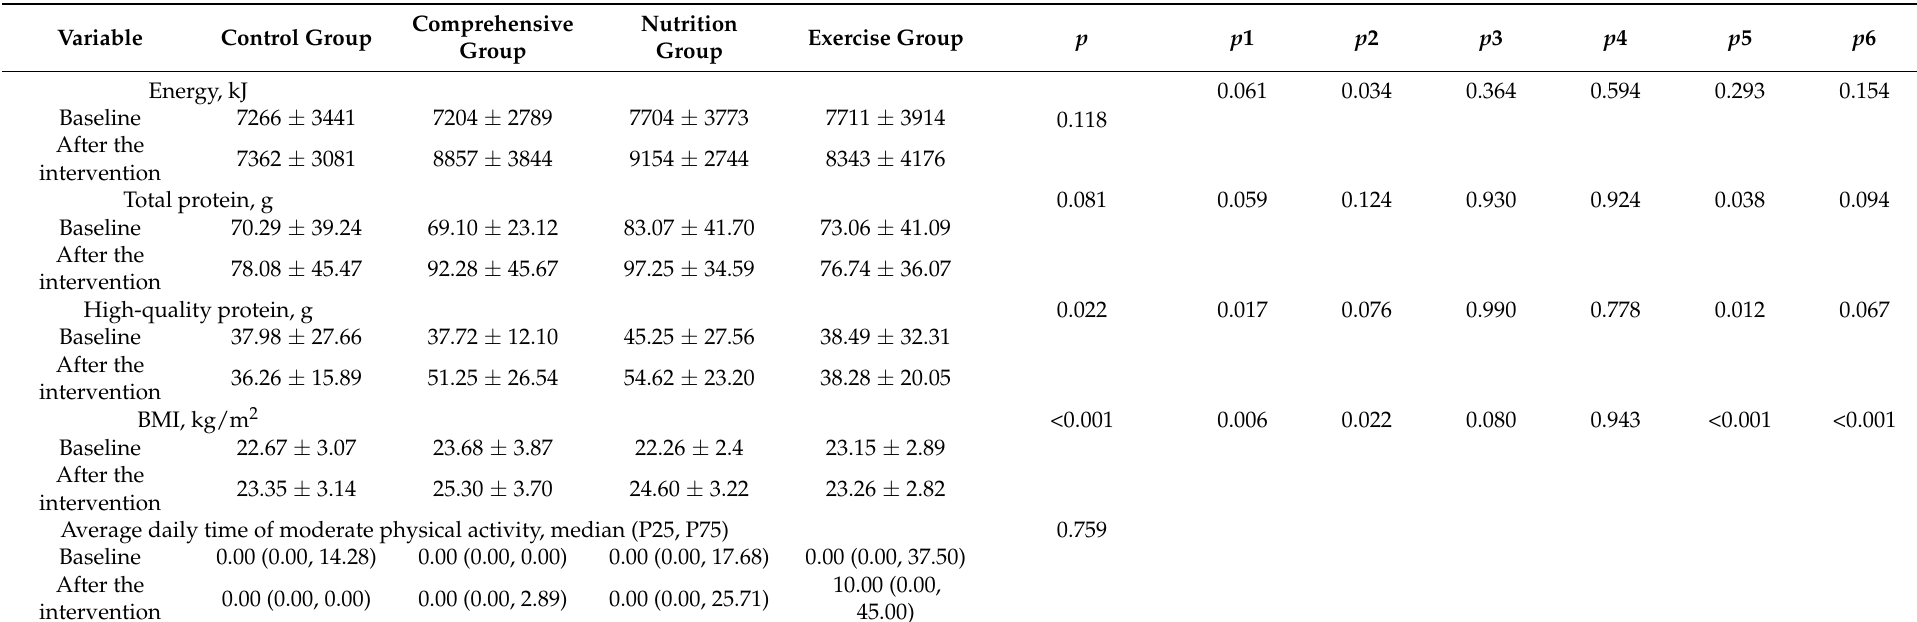
Table 3. Comparison of nutrient intake and exercise status before and after the